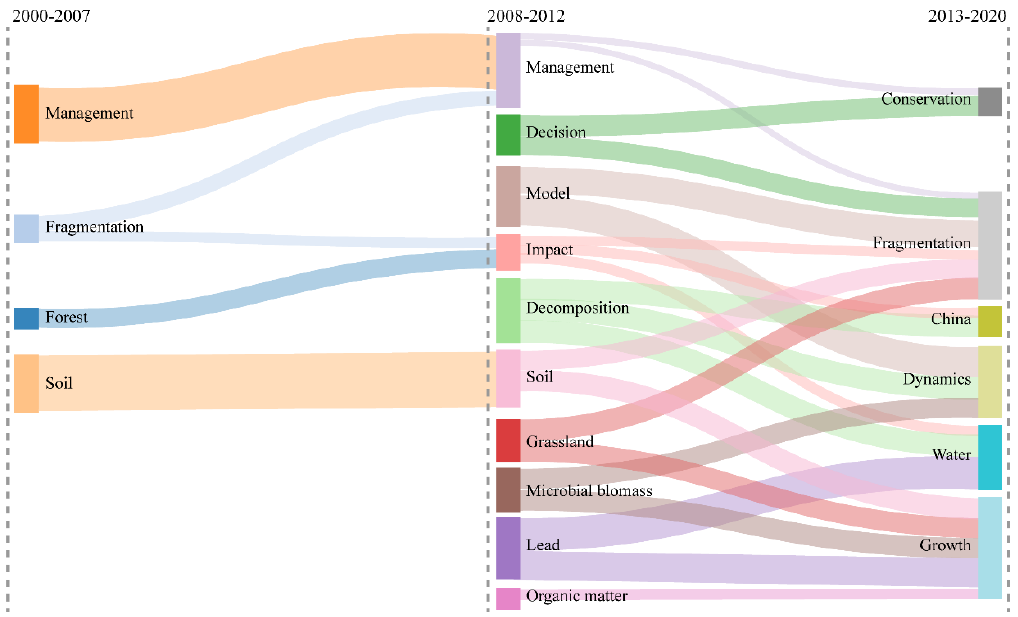
Figure 13. Thematic evolution of the land consolidation research field (2000–2020).